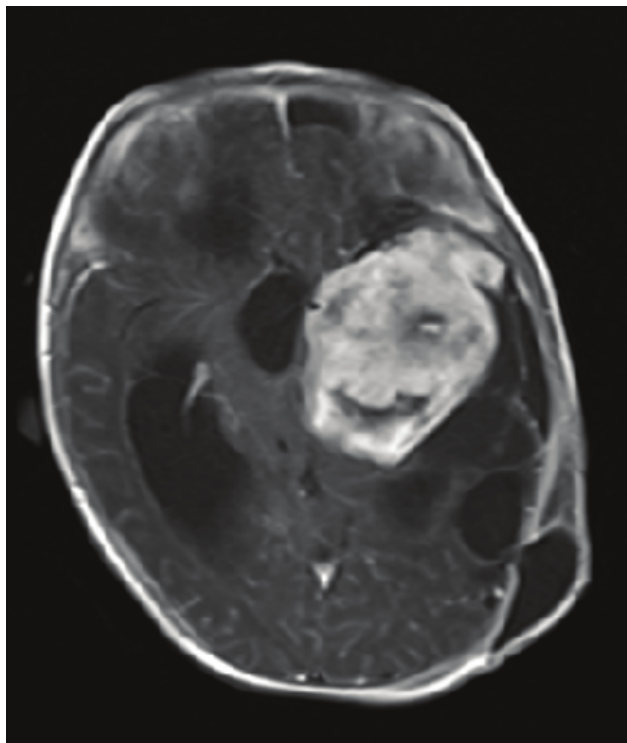
Figure 1 : Initial brain MRI. Axial contrast-enhanced T1-weight imaging showed a large area of signal abnormality with an inhomogeneous space-occupying lesion which replaced the left temporal